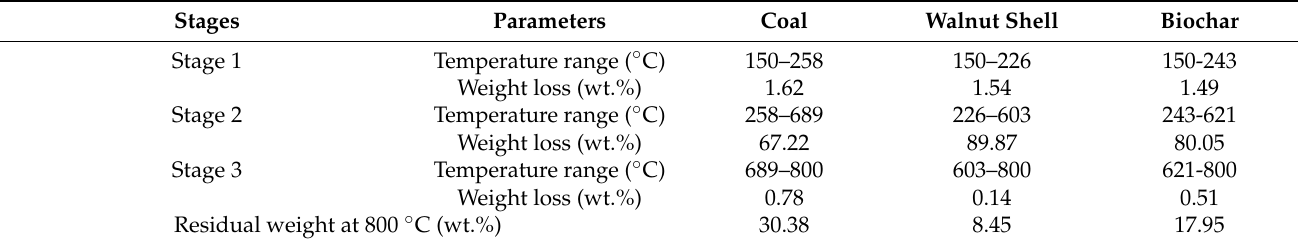
Figure 1. TG and DTG curves of ( a , b ) coal, ( c , d ) walnut shell, and ( e , f ) biochar at different heating rates of 10, 20, and 30 °C/min. Table 2. The degradation parameters of the individual